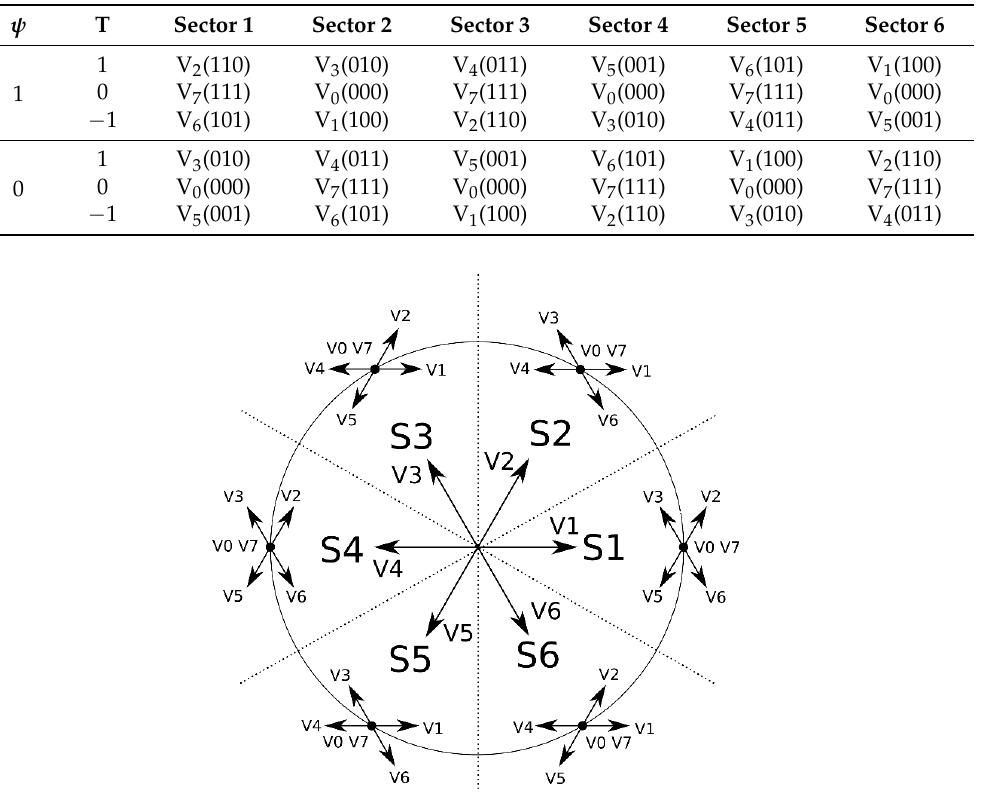
Figure 2. Possible voltage vectors that can be applied in case of the DTC. In every flux sector, only six voltage vectors can be applied (four active and two passive).